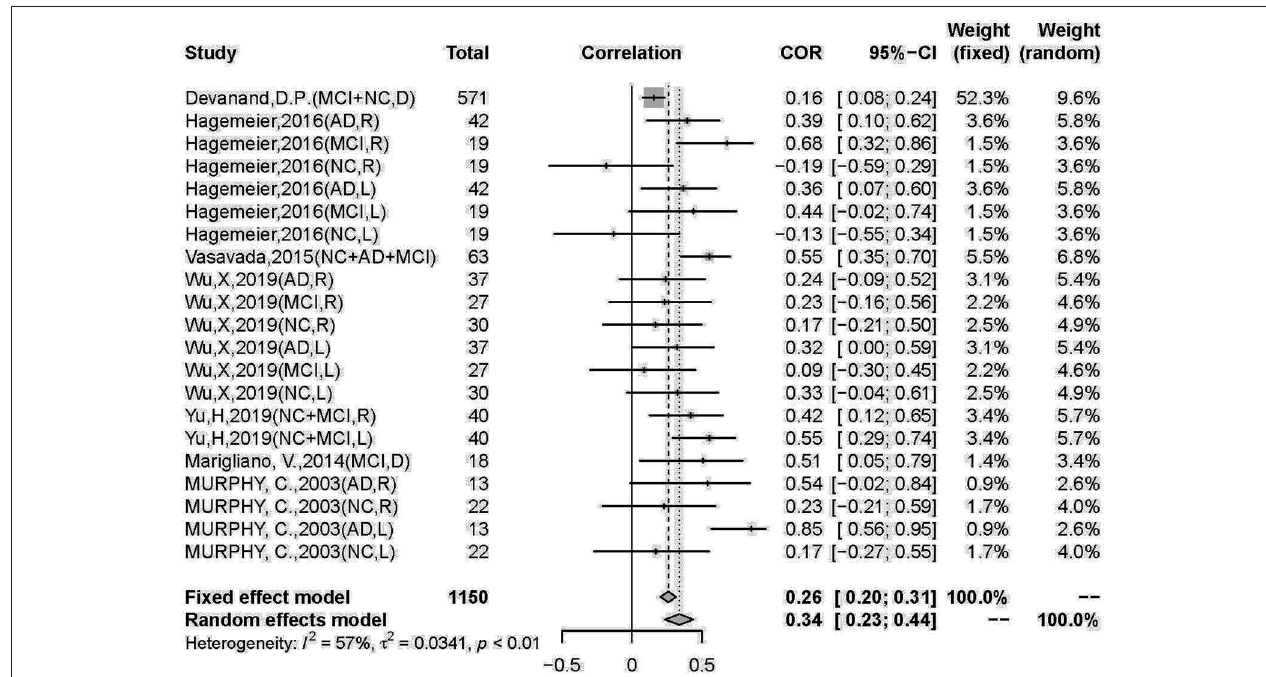
FIGURE 2 | Forest plot summarizing the overall correlation between odor identification score and hippocampal volume across all studies and their 95% interval for each study. (Random effects model selected. NC, normal control; AD, Alzheimer’s disease; MCI, mild cognitive impairment; D, hippocampal volume measurement in double sides; R, hippocampal volume measurement in right side; L, hippocampal volume measurement in left side).